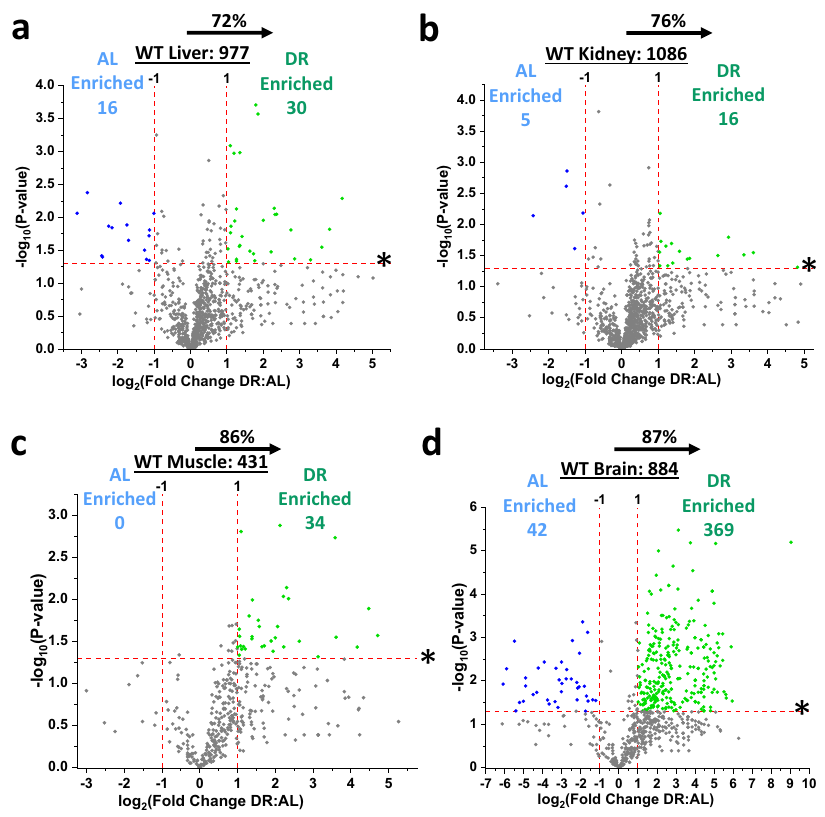
Fig. 2 Dietary restriction enriches the persul fi dation pro fi les in liver, kidney, muscle, and brain. a – d Volcano plots showing differentially abundant persul fi dated proteins in liver ( a ), kidney ( b ), quadriceps muscle ( c ), and whole brain ( d ) from ad libitum (AL; n = 4 mice/group) versus 50% dietary restriction (DR; n = 5 mice/group) fed cystathionine γ -lyase (CGL) wildtype (WT) mice. The log 2 (Fold Change DR:AL) X-axis displays the average fold change in spectral counts for each identi fi ed persul fi dated protein while the − log 10 Y-axis displays the calculated P value when comparing the individual spectral count values for each identi fi ed persul fi dated protein in a speci fi c tissue from AL versus DR fed mice via a two-sided Student ’ s t test. The non-axial red dotted vertical lines highlight the biological signi fi cance threshold of + / − twofold change in spectral counts between DR versus AL, while the non-axial red dotted horizontal line with asterisk highlights our statistical signi fi cance threshold of P < 0.05. The number of total persul fi dated proteins identi fi ed in each tissue are given next to the tissue name, while blue (AL enriched) and green (DR enriched) colored dots and text indicate persul fi dated proteins reaching both biological- and statistical-thresholds. Gray color dots indicate persul fi dated proteins not reaching the criteria for both biological and statistical signi fi cance for enrichment under either diet. The percentage of proteins skewed toward DR is provided above the tissue label. See also Supplementary Fig.